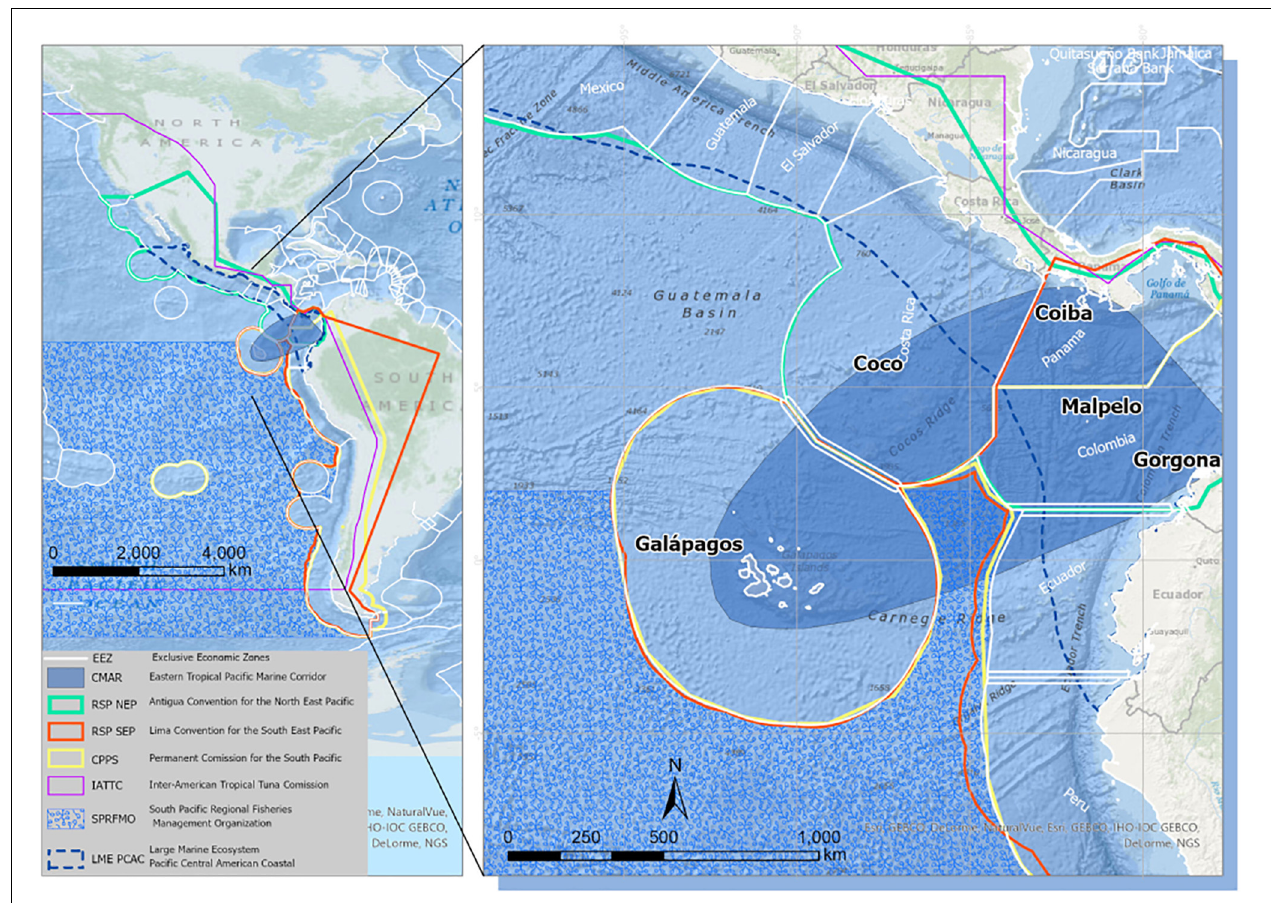
FIGURE 3 | Regional Ocean Governance in the Eastern Tropical